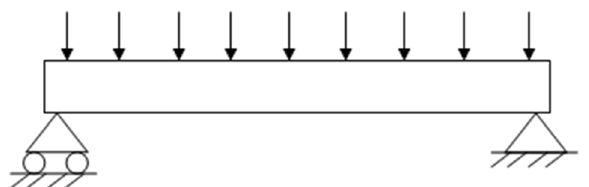
Figure 14. Schematic diagram of beam loading .